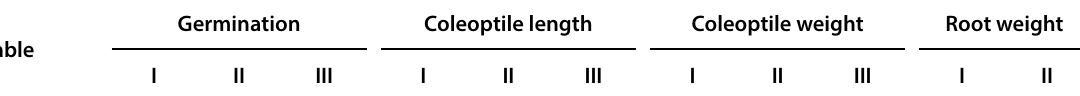
Table 3. Correlation coefficients (Pearson test) between seedling variables (% of control) measured in Experiments I, II and III of a Petri-dish assay after inoculation with Fusarium graminearum